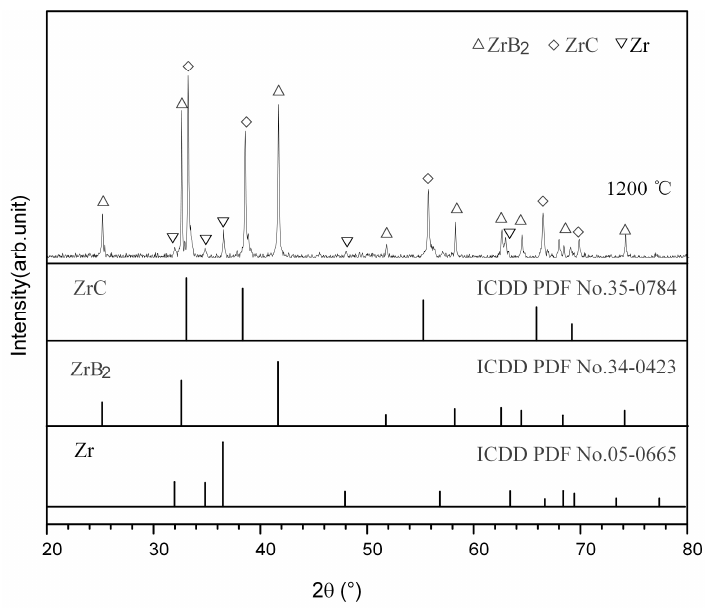
Figure 2. XRD pattern for the DSC product of the Zr-B 4 C mixture heated to 1200 °C.